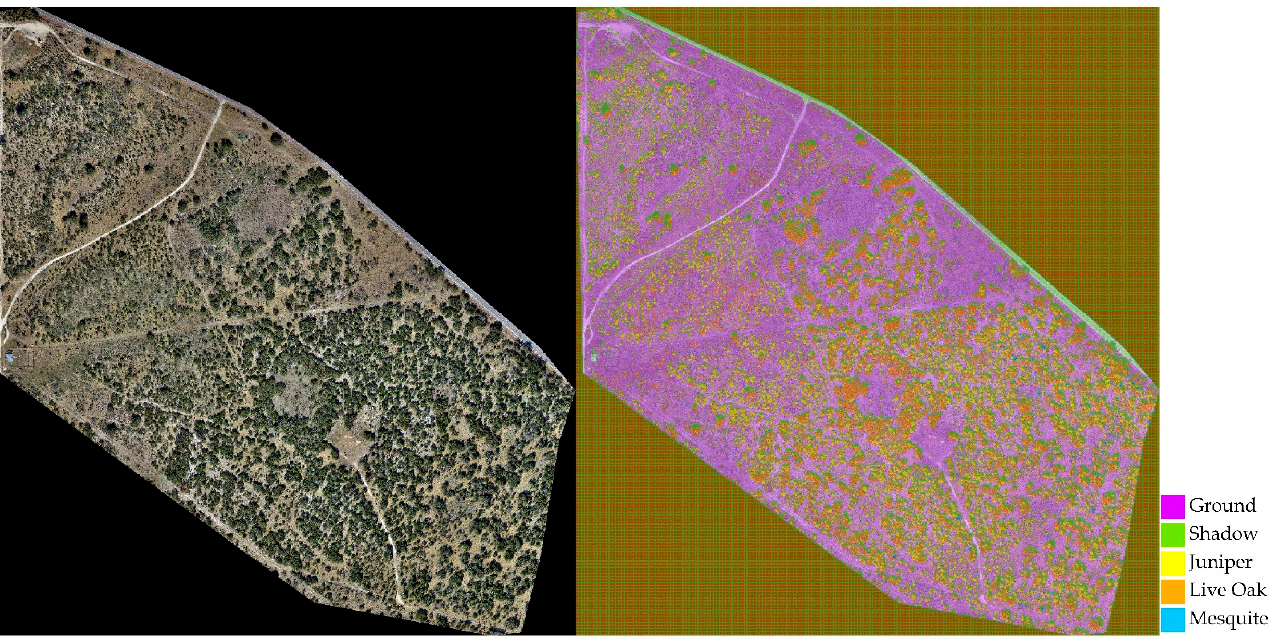
Table 5 . User and producer accuracies for the traditional and machine learning methods .